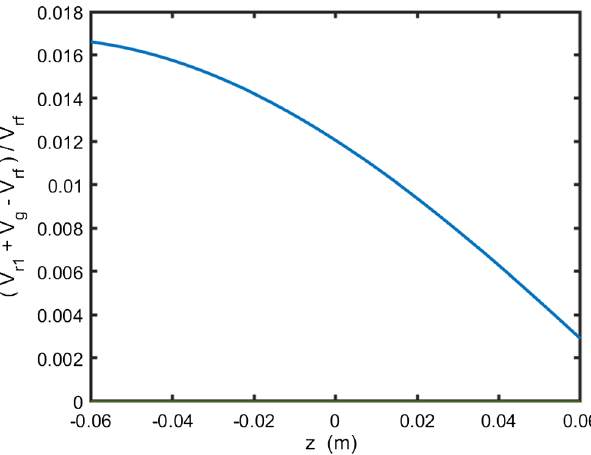
þ V from V r 1 g rf